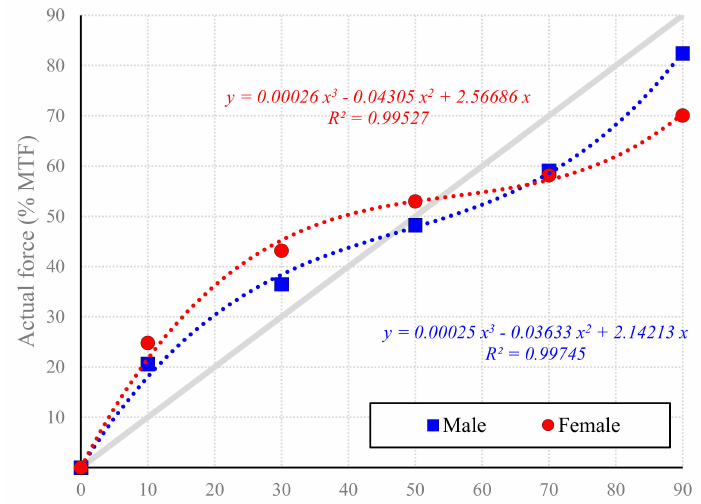
Figure 4. Interaction e ff ect of gender and perceived exertion levels